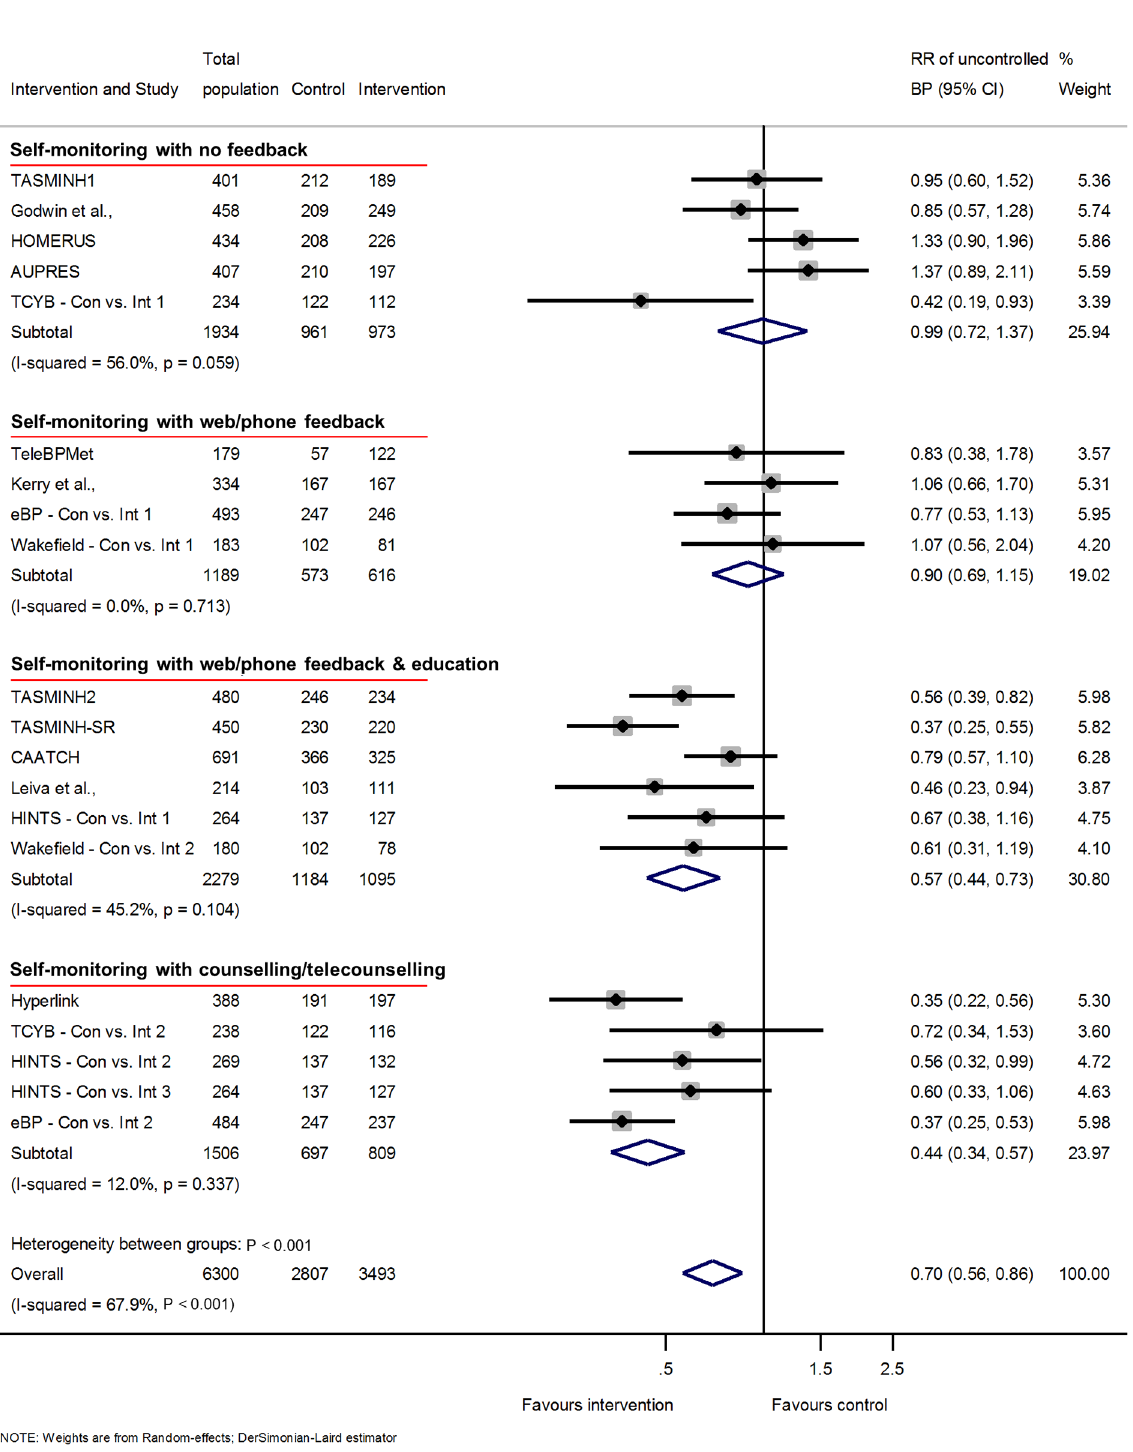
PLOS Medicine| https://doi.org/10.1371/journal.pmed.1002389 September 19,